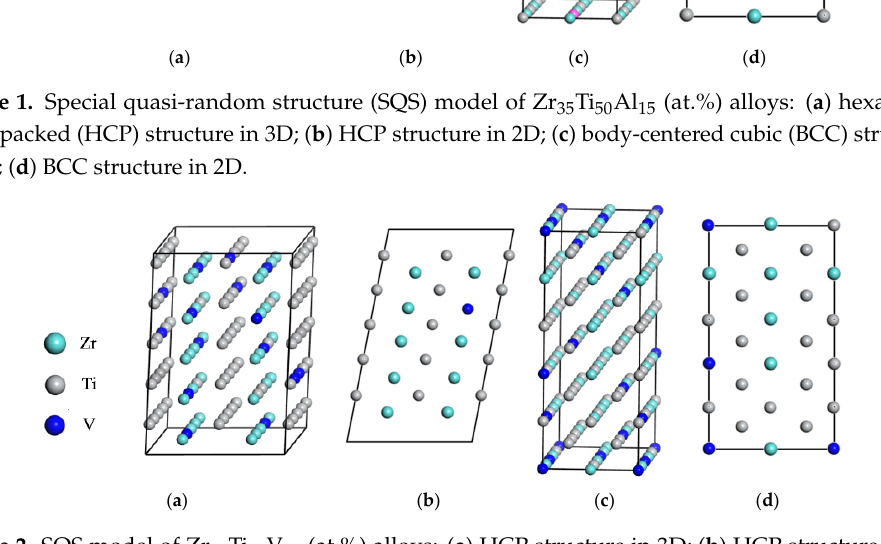
Figure 2. SQS model of Zr 35 Ti 50 V 15 (at.%) alloys: ( a ) HCP structure in 3D; ( b ) HCP structure in 2D; ( c ) BCC structure in 3D; ( d ) BCC structure in 2D. Table 1. Zr-Ti-Al alloy systems in HCP structure and BCC structure with different atomic fraction of Al. Structures